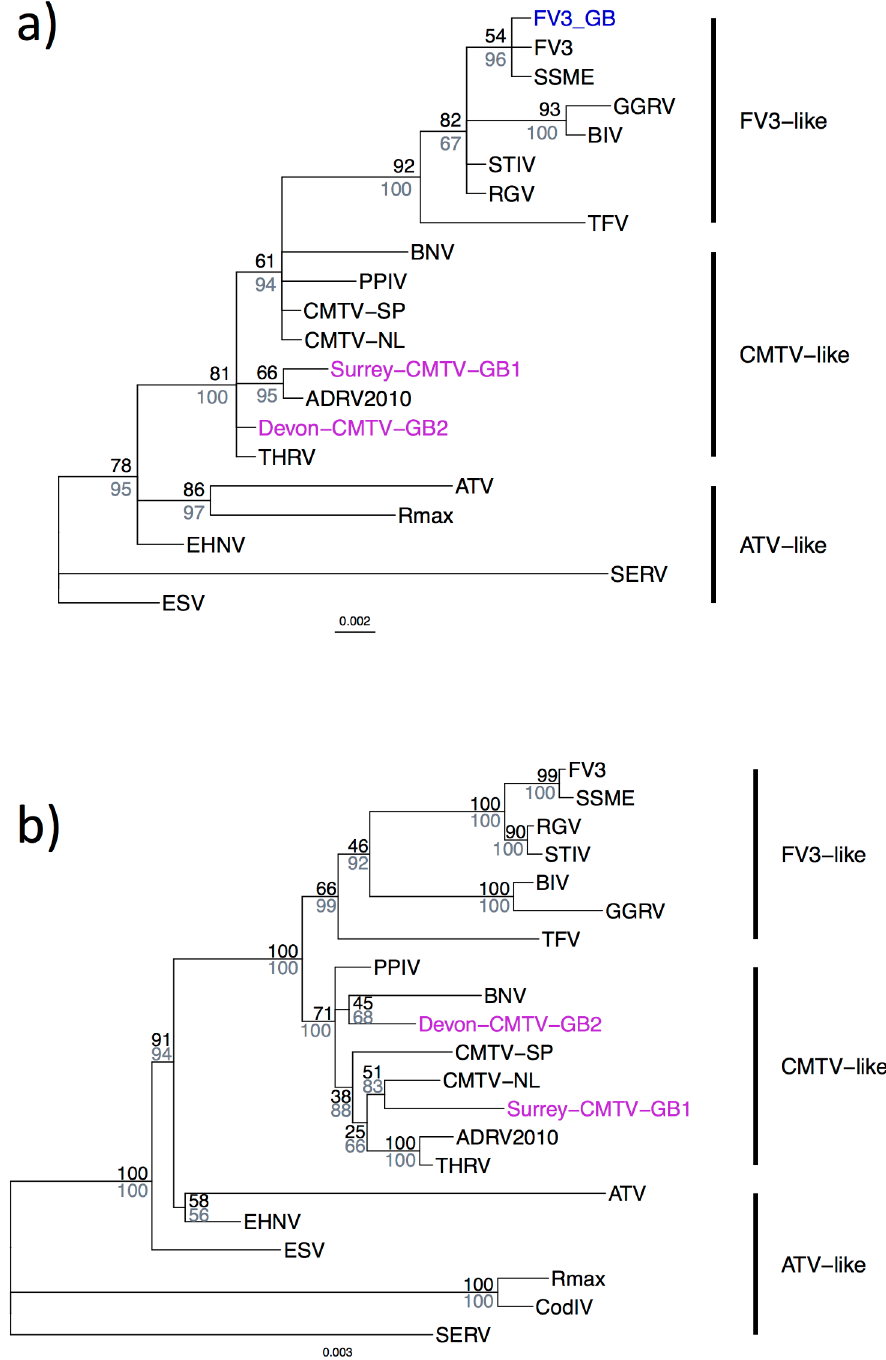
Fig 3. Diversity among ranaviruses detected in Great Britain in the context of amphibian-like ranavirusisolates occurring globally. (a) Phylogeneticreconstruction of Ranavirus relationships using a partial sequenceof the major capsid protein gene (MCP); alignment length = 480 base pairs. British Ranavirus isolates were named accordingto their phylogenetic position:two British isolates belongedto the CMTV-like viruses (Surrey-CMTV-GB1 & Devon-CMTV-GB2, labelledin purple). British Frog virus 3 (FV3)- like viruses shared100% identity at the MCP and were groupedas ‘FV3-GB’ (blue). (b) Phylogenetic relationships based on a concatenated alignmentcomprisingthe MCP and five additional partial coding sequences(comprisingSpanishcommon midwife toad ranavirus[CMTV-SP; GenBankaccessionJQ231222]